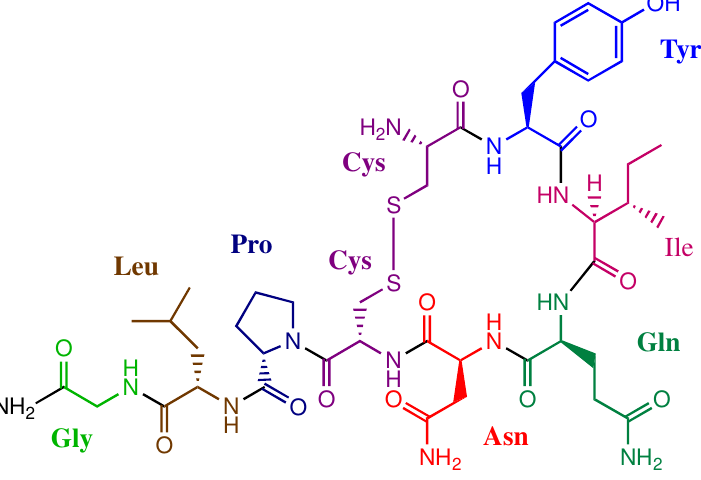
Figure 1. The structure of Oxytocin, which has an intramolecular disulphide linkage forming the cyclic structure.